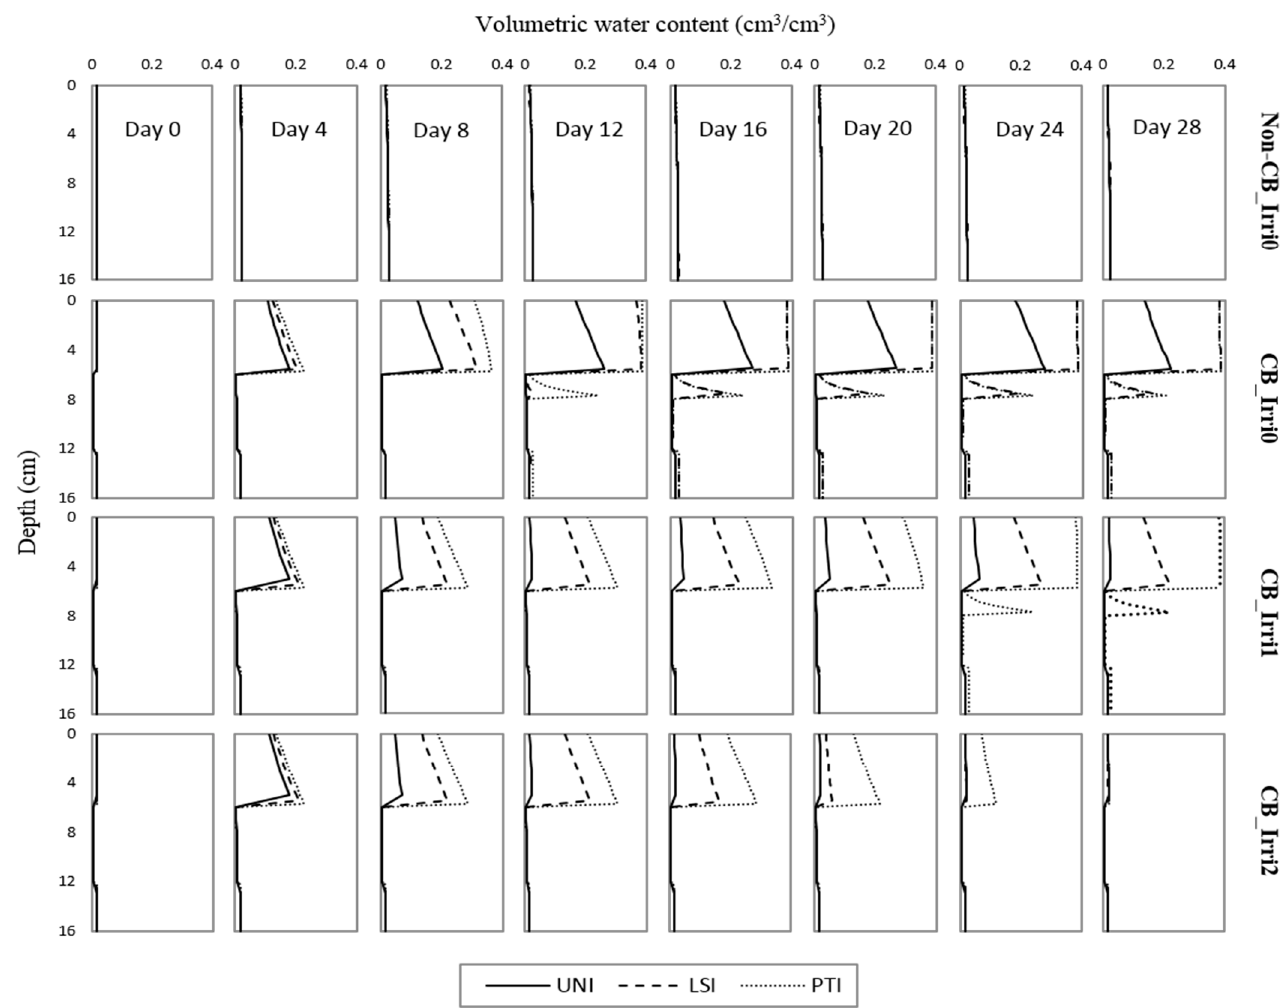
Figure 9. Profiles of volumetric soil water contents at the center of the domains obtained from the model for uniform, line-source, plant-targeted irrigation (UNI, LSI, and PTI, respectively) at different times (0, 4, 8, 12, 16, 20, 24 and 28 day) and for different simulation setups with free bottom drainage (Non-CB_Irri0, CB_Irri0, CB_Irri1, and CB_Irri2).